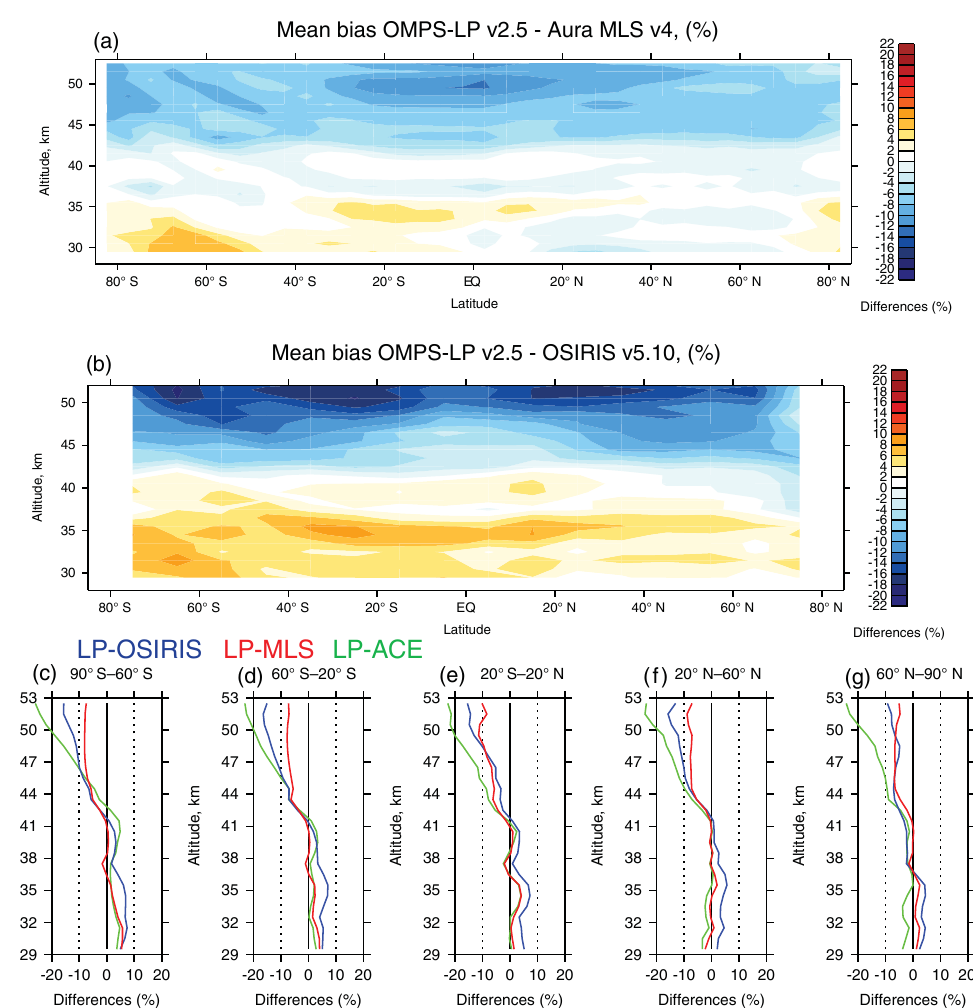
Figure 8. Mean biases for the UV ozone retrievals from OMPS LP version 2.5 against correlative satellite measurements. Panel (a) shows the bias with Aura MLS version 4 as a function of latitude (on 5 ◦ latitude grid) and height. Panel (b) shows the bias with Odin OSIRIS version 5.10 (on 10 ◦ latitude grid). Panels (c–g) illustrate vertical structures of the mean biases against Aura MLS (red), Odin OSIRIS (blue) and ACE-FTS (green) in five wide latitude bins. The standard error of the mean is smaller than the width of the